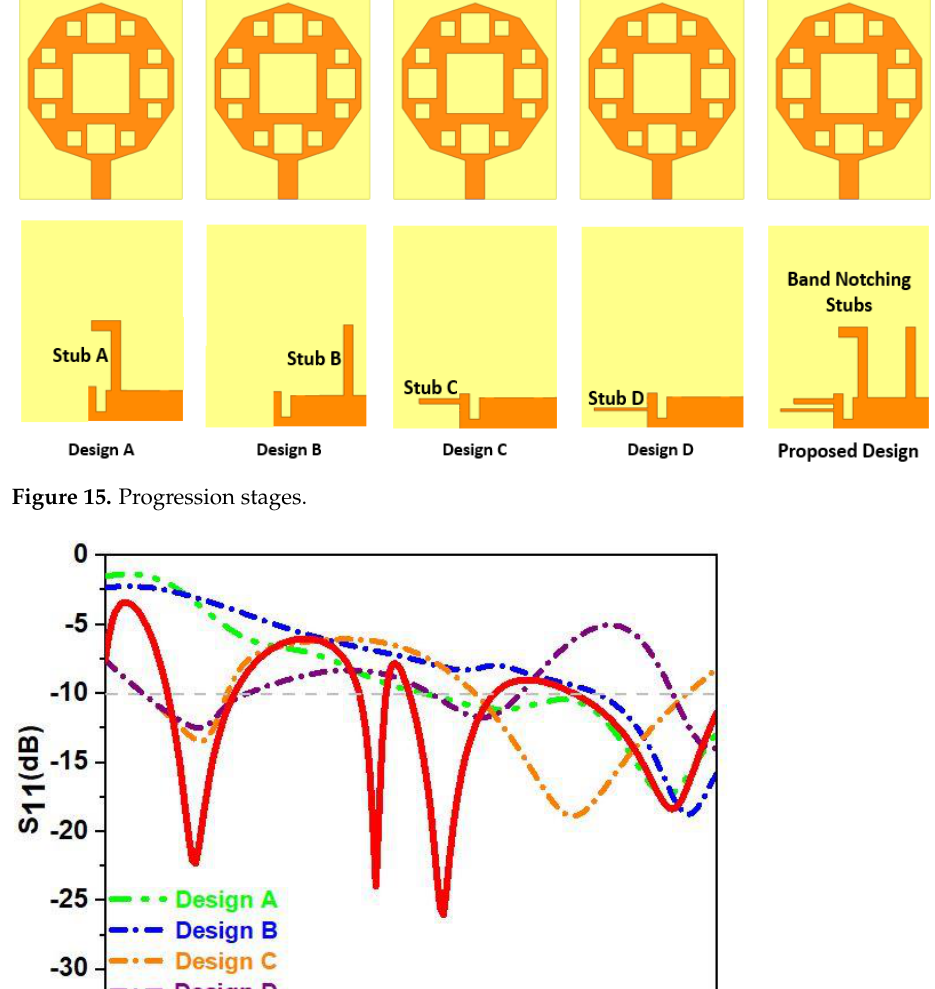
Figure 16. S 11 features of the progression stages.